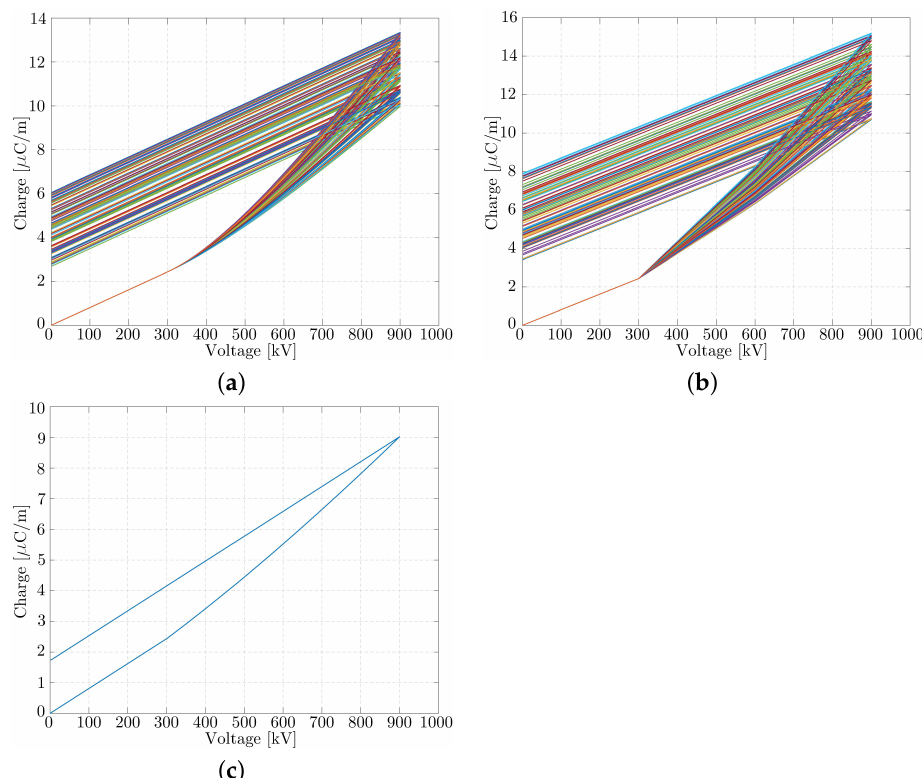
Figure 10. Charge–voltage loops displaying the sensitivity of circuit-based models to the variation of the input parameters. ( a ) Hara and Humoto, ( b ) Motoyama and Ametani, ( c ) Maccioni-Araneo et